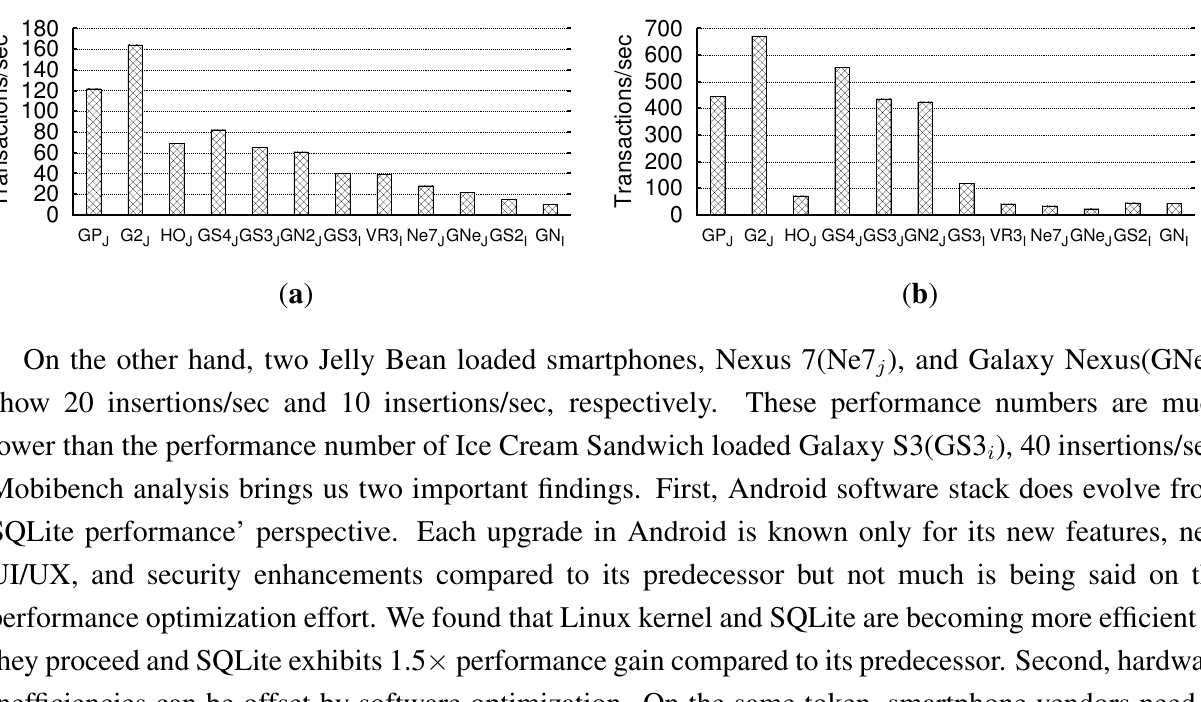
SQLite insert and update performance on twelve smartphone models from different smartphone